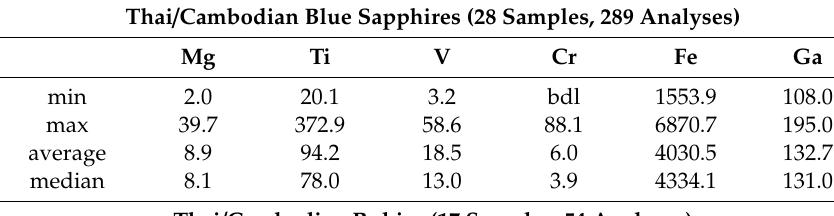
Table 1. Summary of trace elements for Thai / Cambodian sapphires and rubies in ppm.